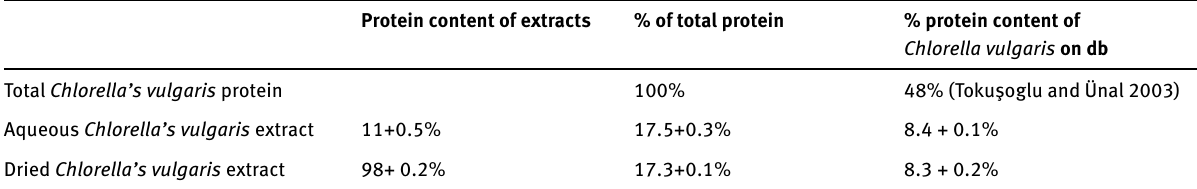
Protein content of